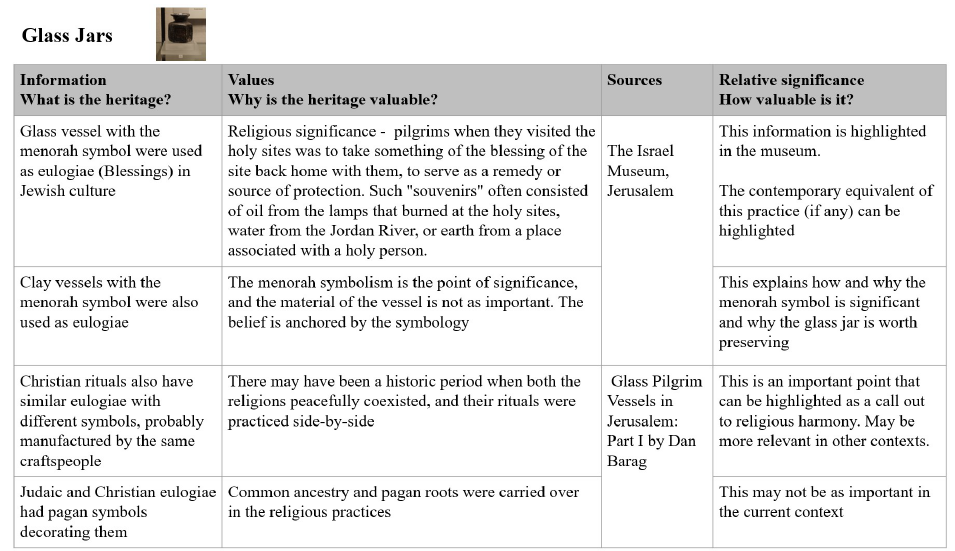
Figure 6. Content design structure showing the relative importance of the information and values associated with the ‘Glass Jar’ artefact in the Menorah